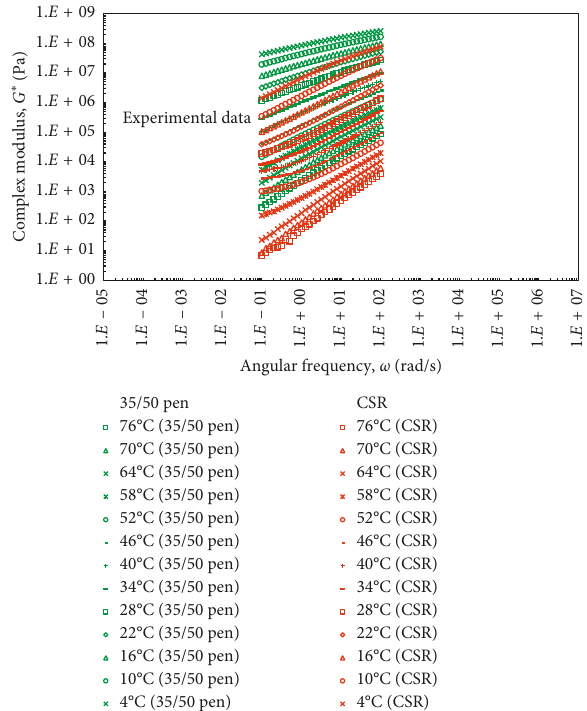
Figure 18: Experimental results of stiffness ( G vs. CSR.